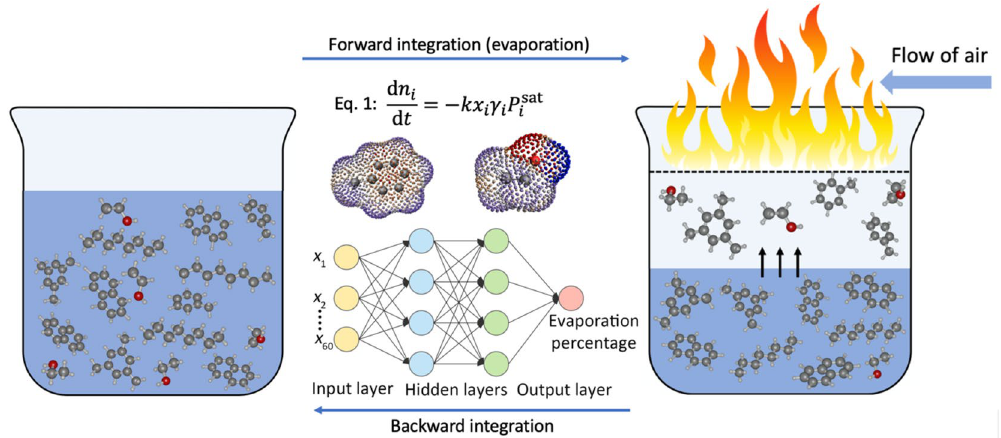
Figure 1. Schematic representation of the weathering process and the used modeling approach. Left: an unweathered (original) gasoline sample, which is found in possession of a suspect. Right: the composition changes or weathering of a gasoline mixture due to fire. A combination of thermodynamic modeling, quantum chemical calculations, and machine learning is used to link the composition of the weathered and unweathered samples. The weathering process is described by Eq. (1), which is based on the gamma-phi approach of vapor– liquid equilibrium calculations. Forward integration of Eq. (1) is used to predict the composition of a weathered sample starting from the original sample. Backward integration of Eq. (1) is used to obtain the composition of the original gasoline starting from a weathered sample. In Eq. (1), n i , x i , γ i , and P i sat are the number of moles, the mole fraction, the activity coefficient, and the saturated vapor pressure of component i in the liquid phase, respectively. Activity coefficients of the multicomponent mixture were obtained from the COSMO-RS model 17